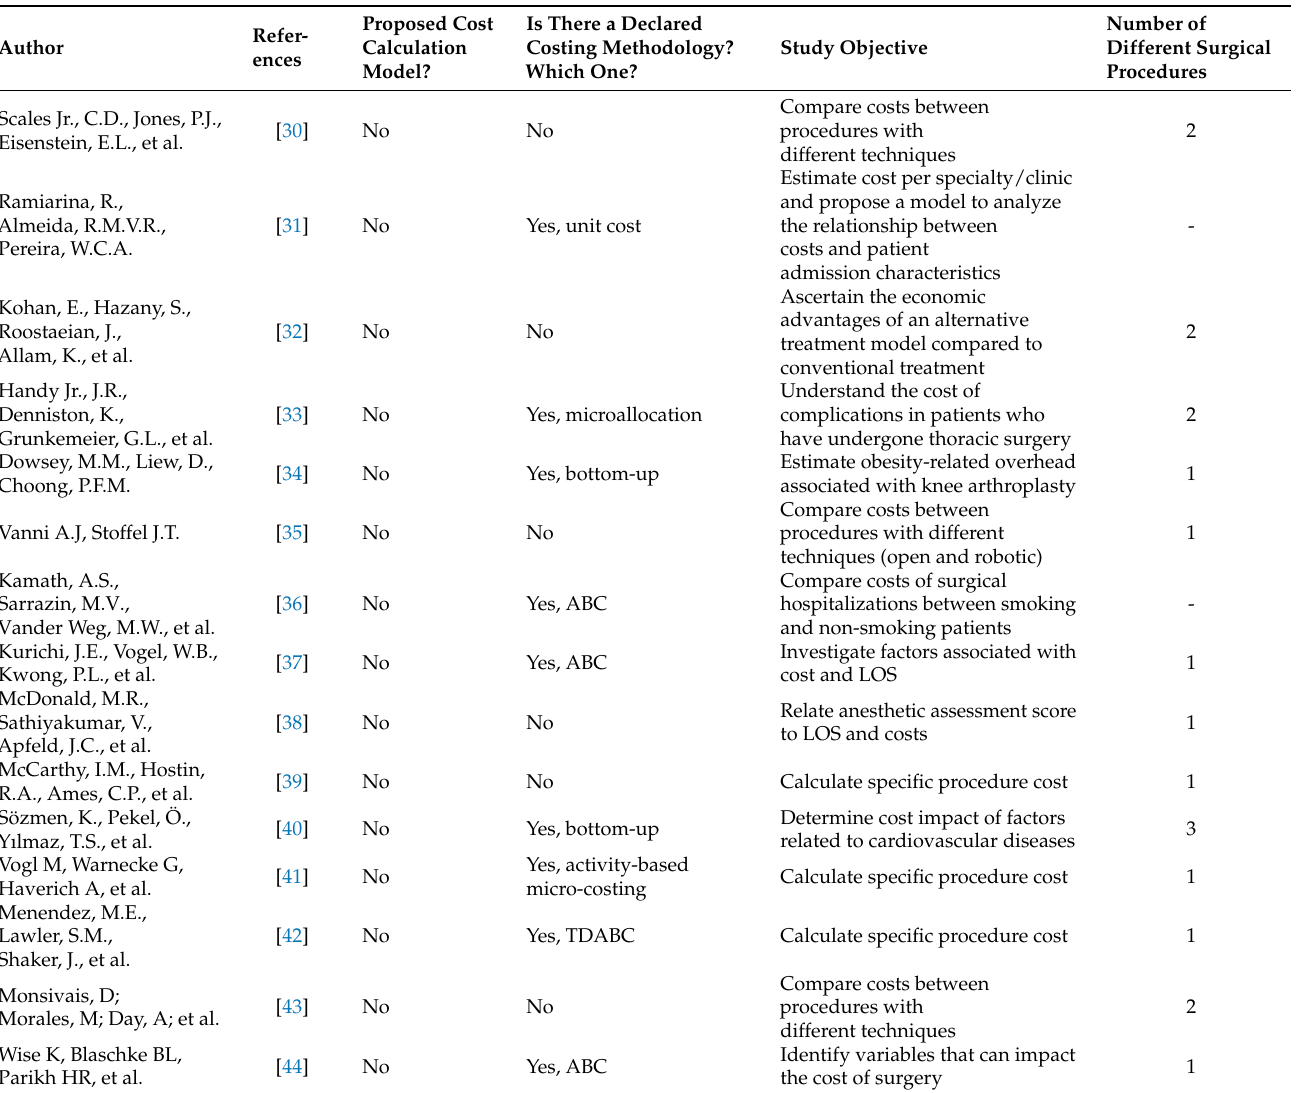
Table 3. Qualitative analysis of the articles included in the